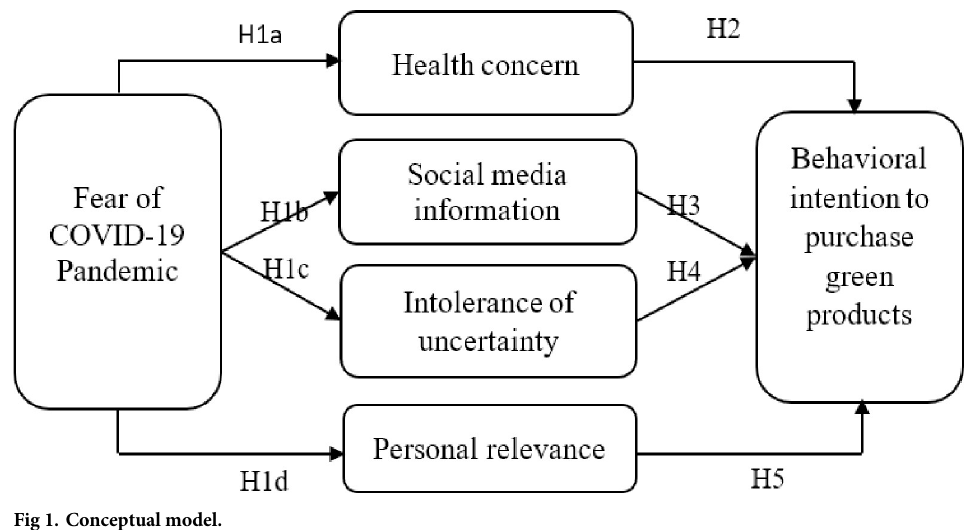
Fig 1. Conceptual